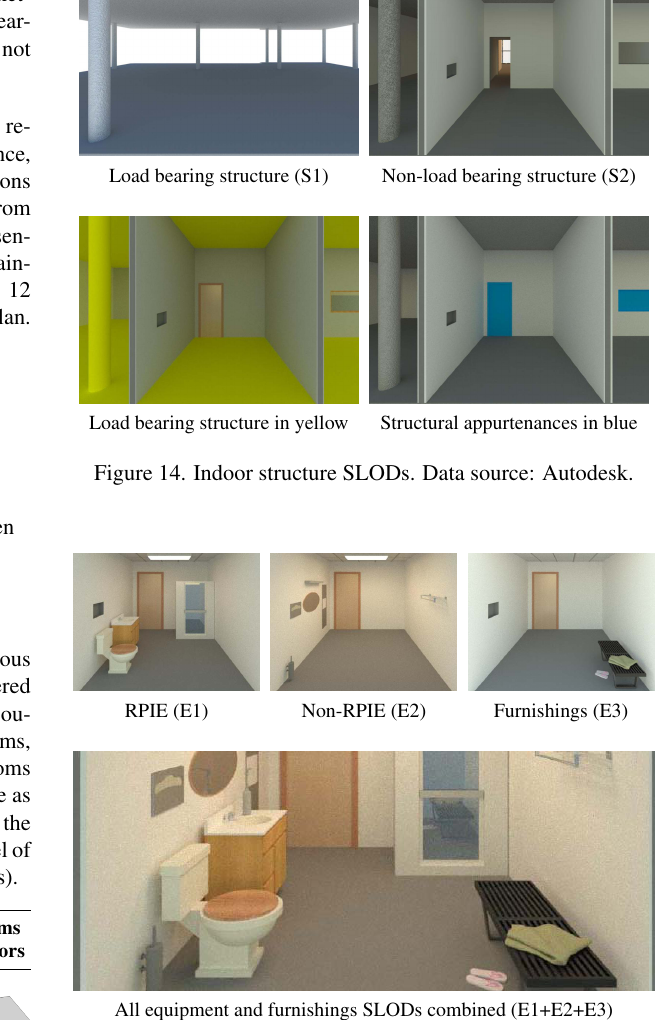
Figure 15. Indoor equipment and furnishings